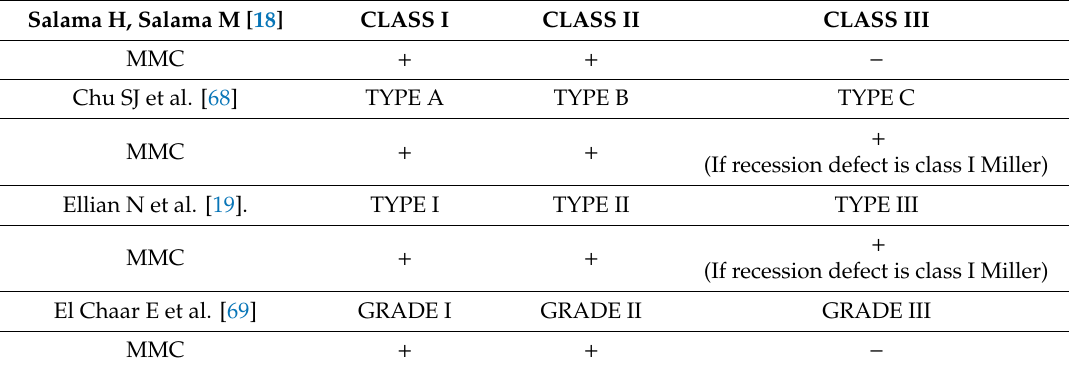
Figure 30. Pre-op (top row) and post-op (bottom row) images of three cases, demonstrating the marginal migration of soft tissue effect achieved with the MMC protocol. Table 1. Summary of different socket classifications available and potential applicability of the MMC protocol.